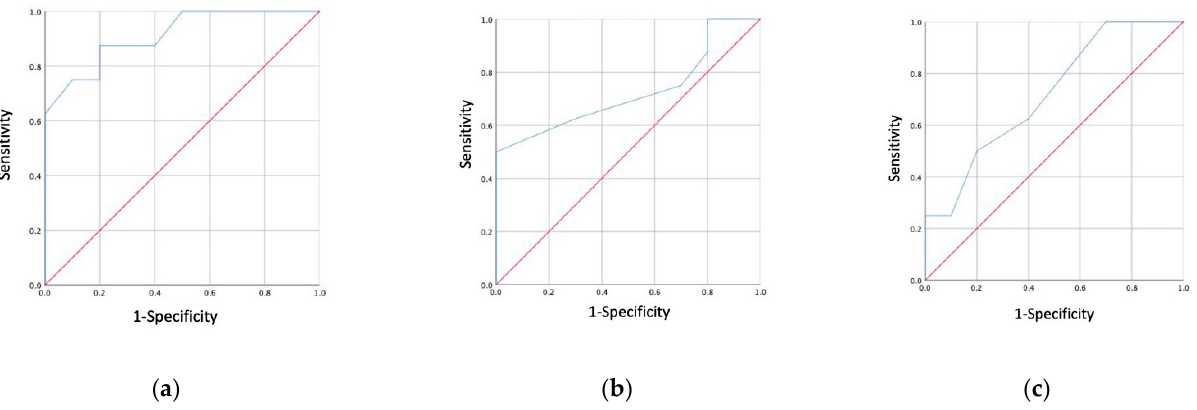
Figure 6. ( a ) The ROC curve of FMA measurement (between molar intrusion treatment and surgical orthodontic treatment); ( b ) the ROC curve of upper molar height measurement (between molar intrusion treatment and surgical orthodontic treatment); ( c ) the ROC curve of upper incisor height measurement (between molar intrusion treatment and surgical orthodontic treatment).